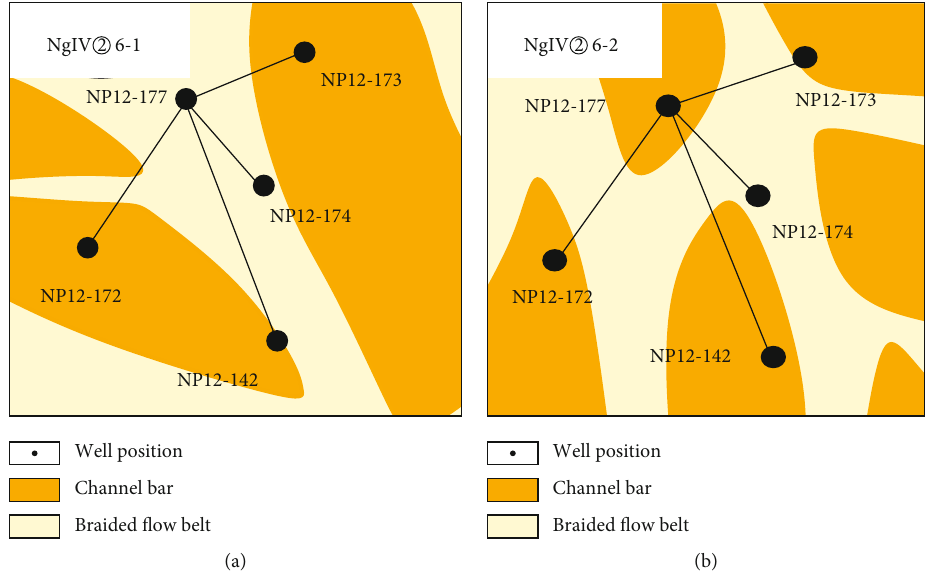
Figure 13: Perforating interval map of well group